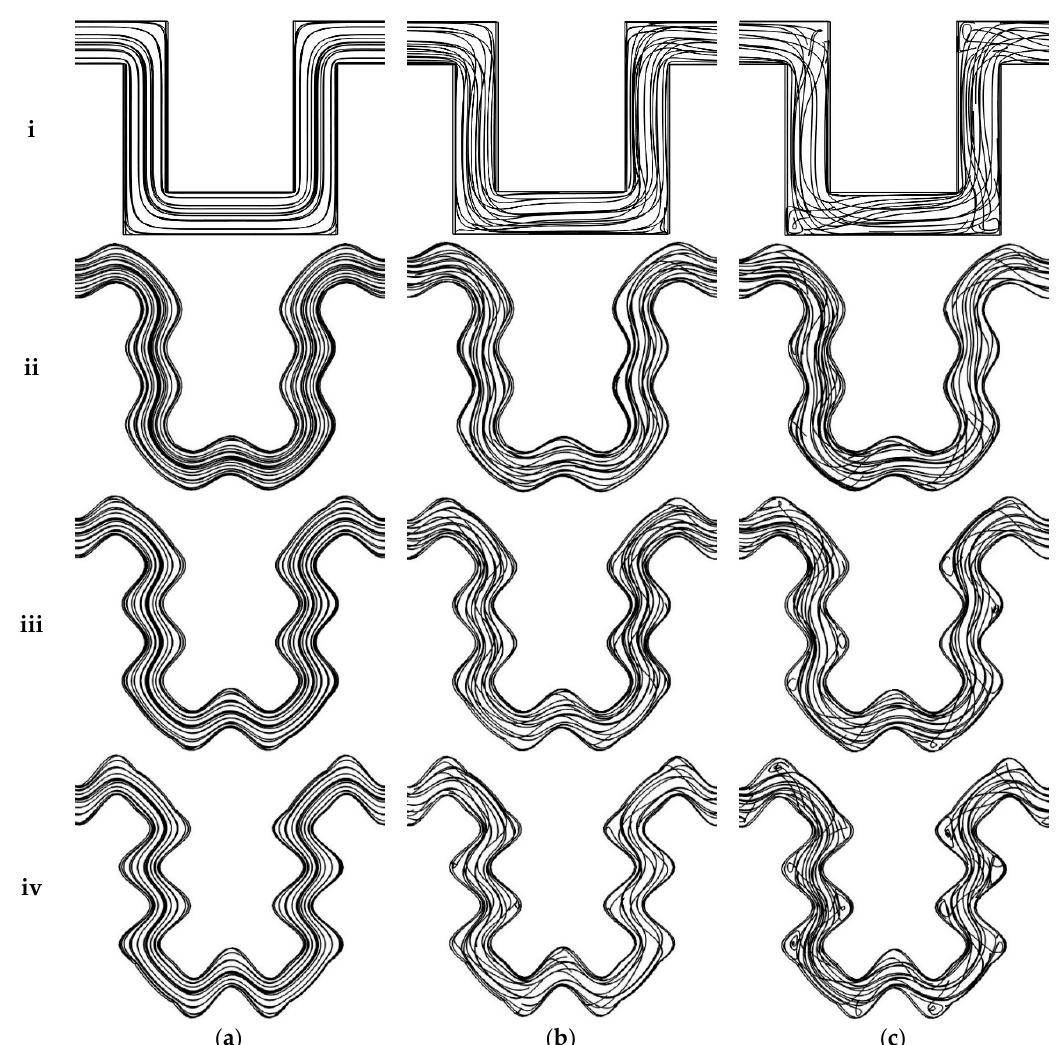
Figure 4. Streamline plots in first U-shaped region of all geometries: ( i ) Case 1; ( ii ) Case 2; ( iii ) Case 3; and ( iv ) Case 4 at ( a ) Re = 0.1; ( b ) Re = 20; and ( c ) Re = 50.